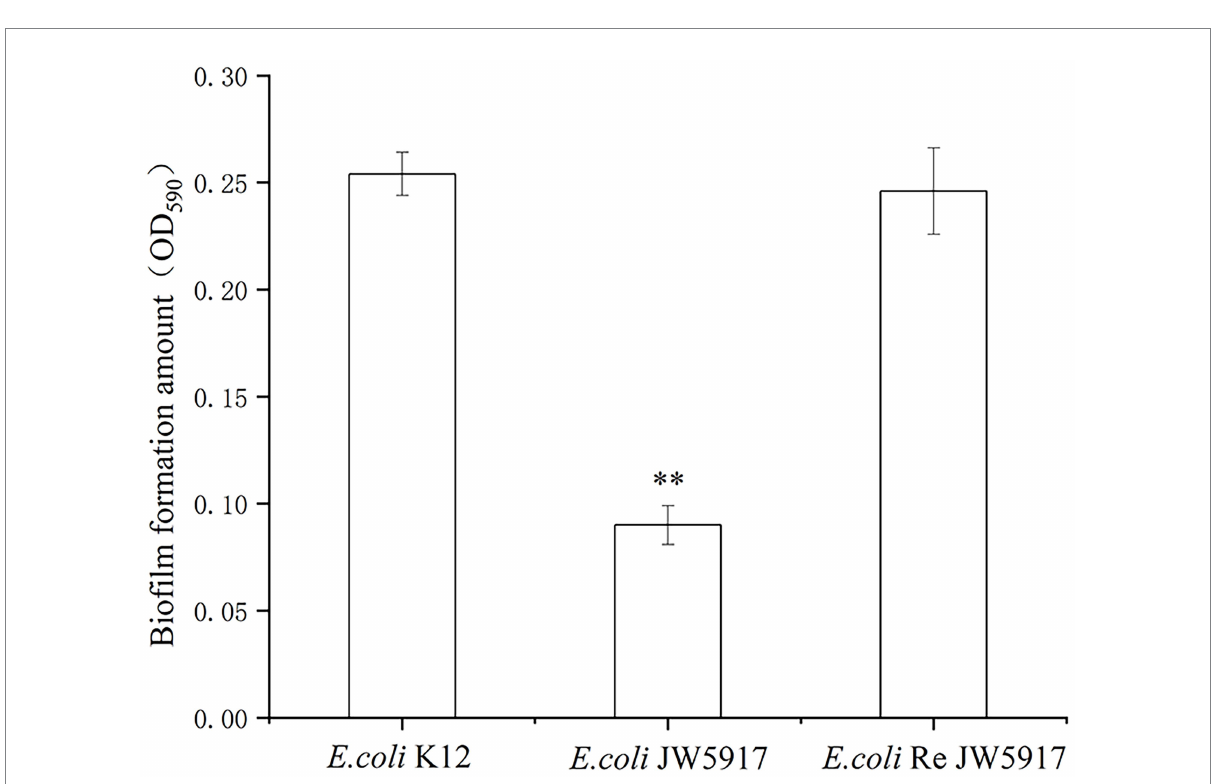
FIGURE 5 Escherichia coli K12, E. coli JW5917, and E. coli ReJW5917 biofilm formation. Biofilm formation detected by absorbance at 590 nm using crystal violet staining. **, significance at p ≤ 0.01.